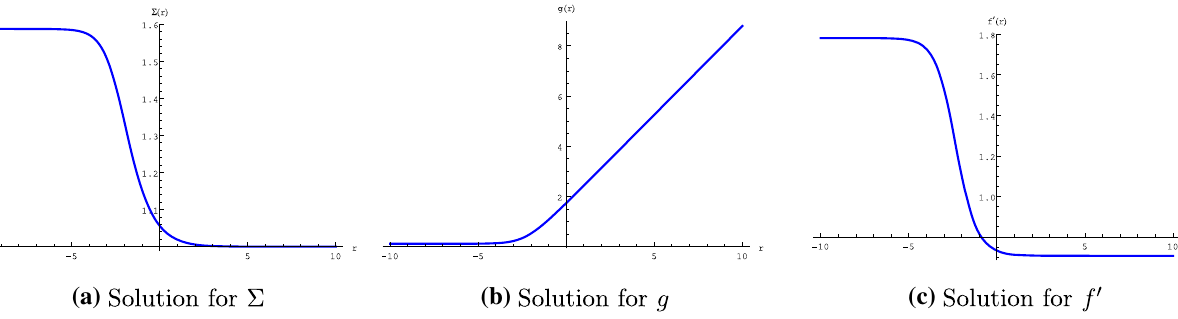
Fig. 10 An RG flow solution from AdS 5 with U ( 1 ) × SO ( 3 ) symmetry to AdS 2 × H 3 geometry in the IR for U ( 1 ) × SO ( 3 , 1 ) gauge group and g 1 =